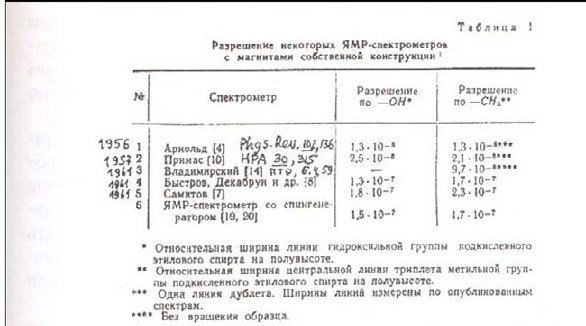
Figure 2. A photocopy of the table from the Lippmaa article that compares the characteristics of the instrument manufactured in his laboratory and the characteristics of the instruments of his prede-